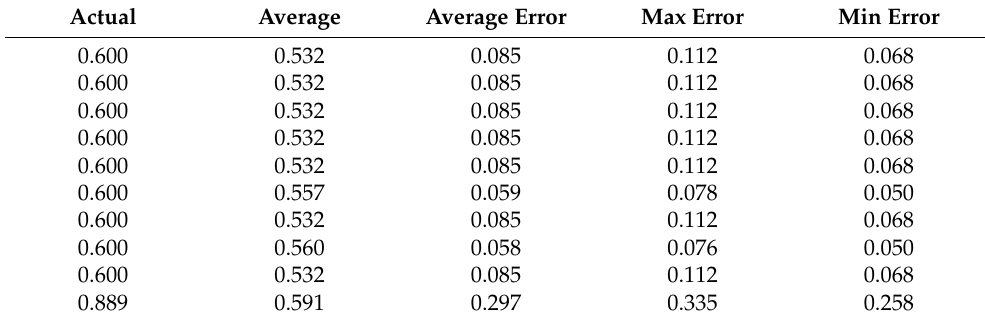
Table A34. Set 1, trials 21–30 data (all 0.5 PR values).